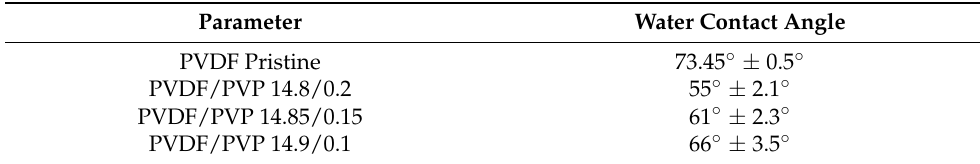
Figure 1. Illustration of the ultrafiltration process. Table 2. Water contact angle of PVDF with various additions of PVP.